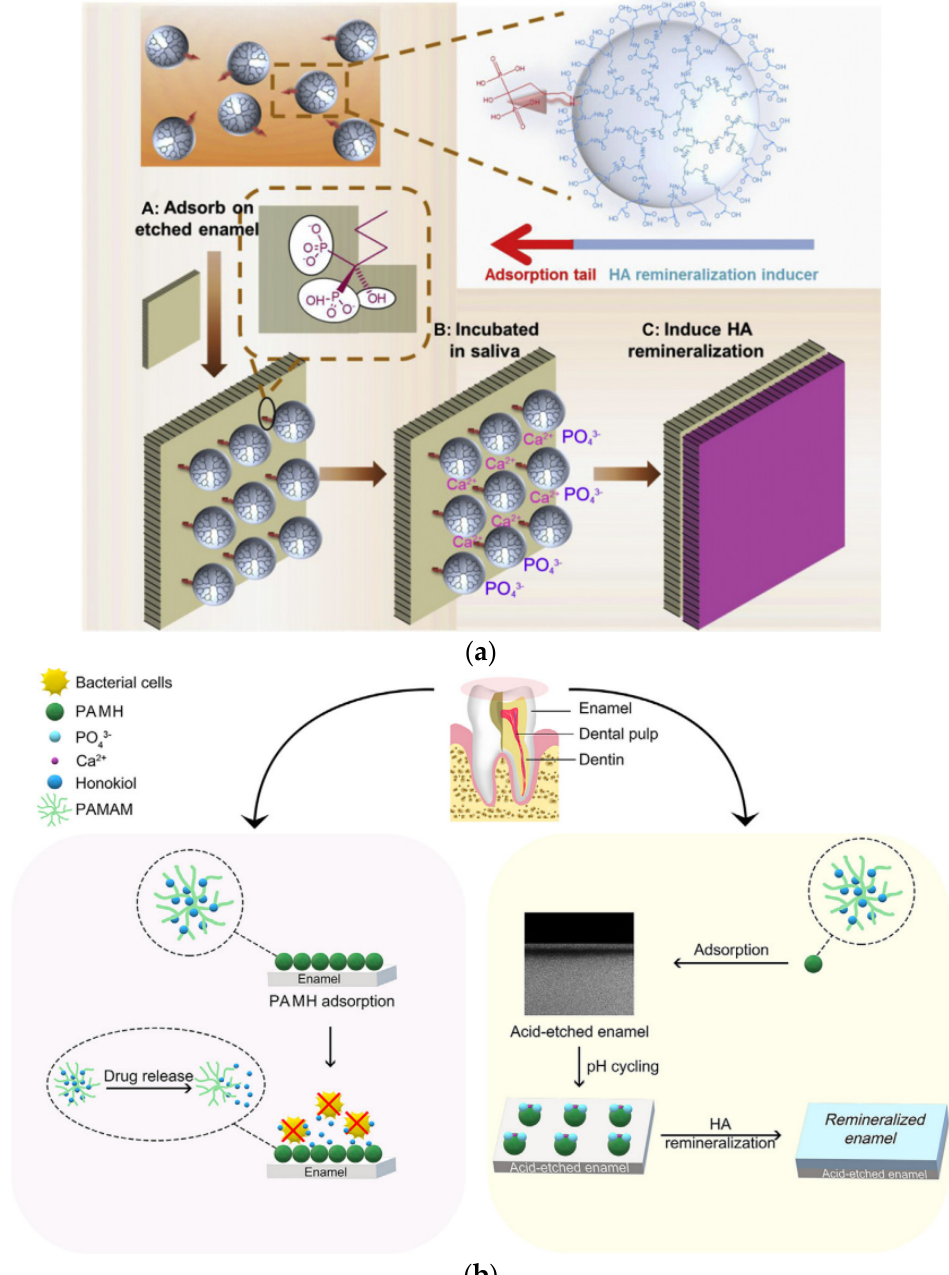
Figure 26. ( a ) Schematic demonstration of the specific adsorption of alendronate-PAMAM-COOH on the surface of tooth enamel and the subsequent in situ remineralization of HA. Reproduced under permission from [252]. Copyright: Elsevier Ltd. ( b ) Schematic demonstration of the mechanisms of PAMAM complex with honokiol (PAMH) for antibacterial and remineralizing effects on enamel, both of which account for anticaries management in the animal experiments of the current study.